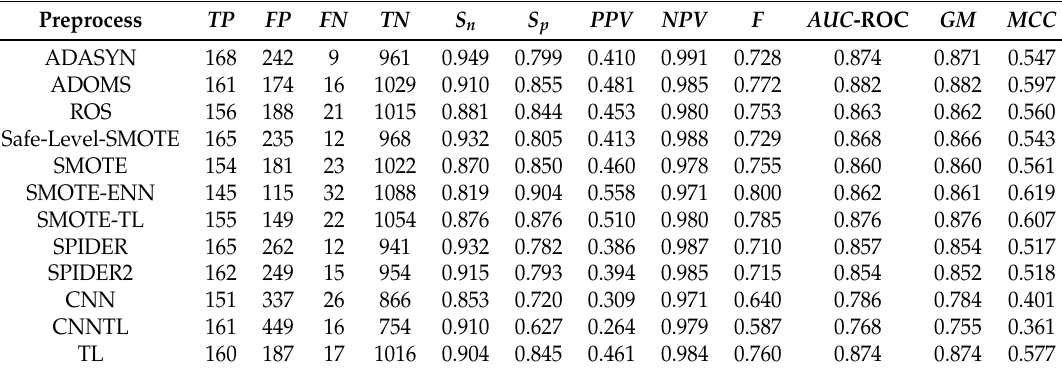
Table 4. Evaluation measures for each preprocessing, when C-SVMCS is